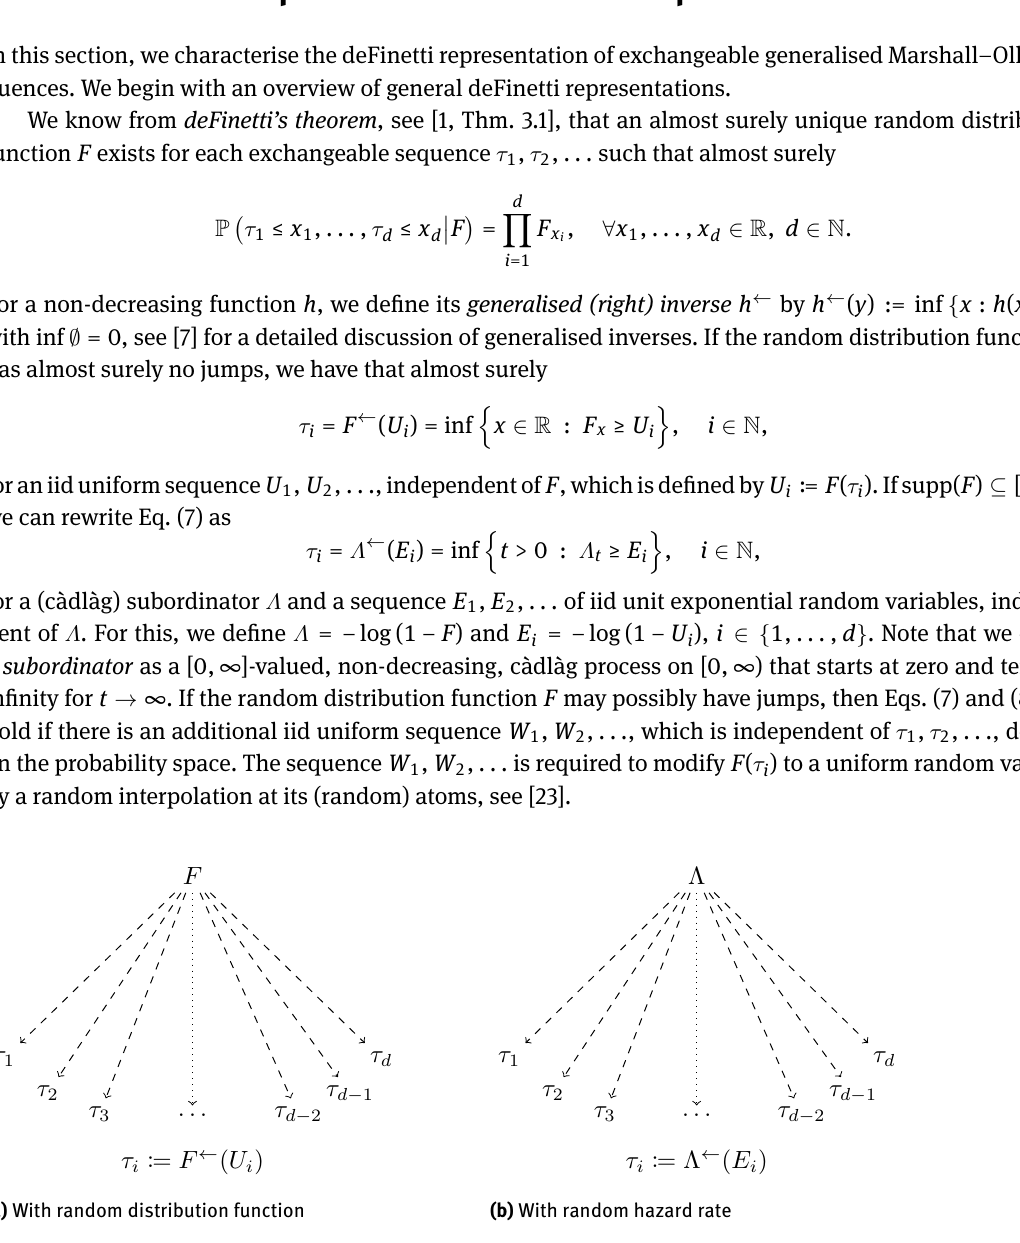
Figure 1: A visualisation of both deFinetti representations: (1) Draw F (resp. Λ ) (2) For each component i , draw U i (resp. E i ) and transform with generalised inverse of F (resp. Λ ). We have F = 1 − exp { − Λ } and U